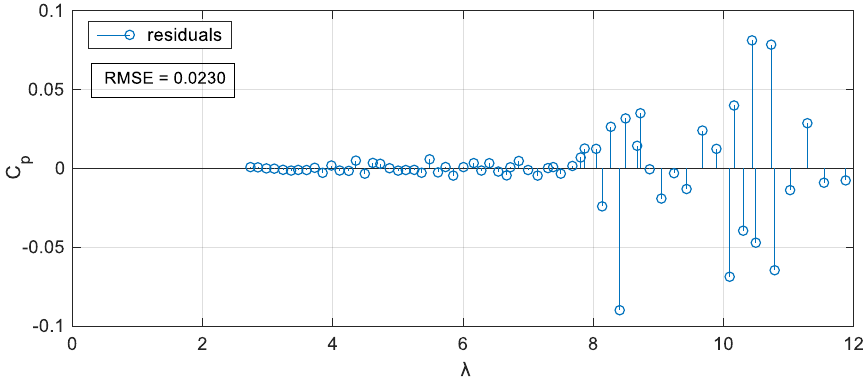
Figure 8. Residuals between the interpolated curve and the points used for interpolation.